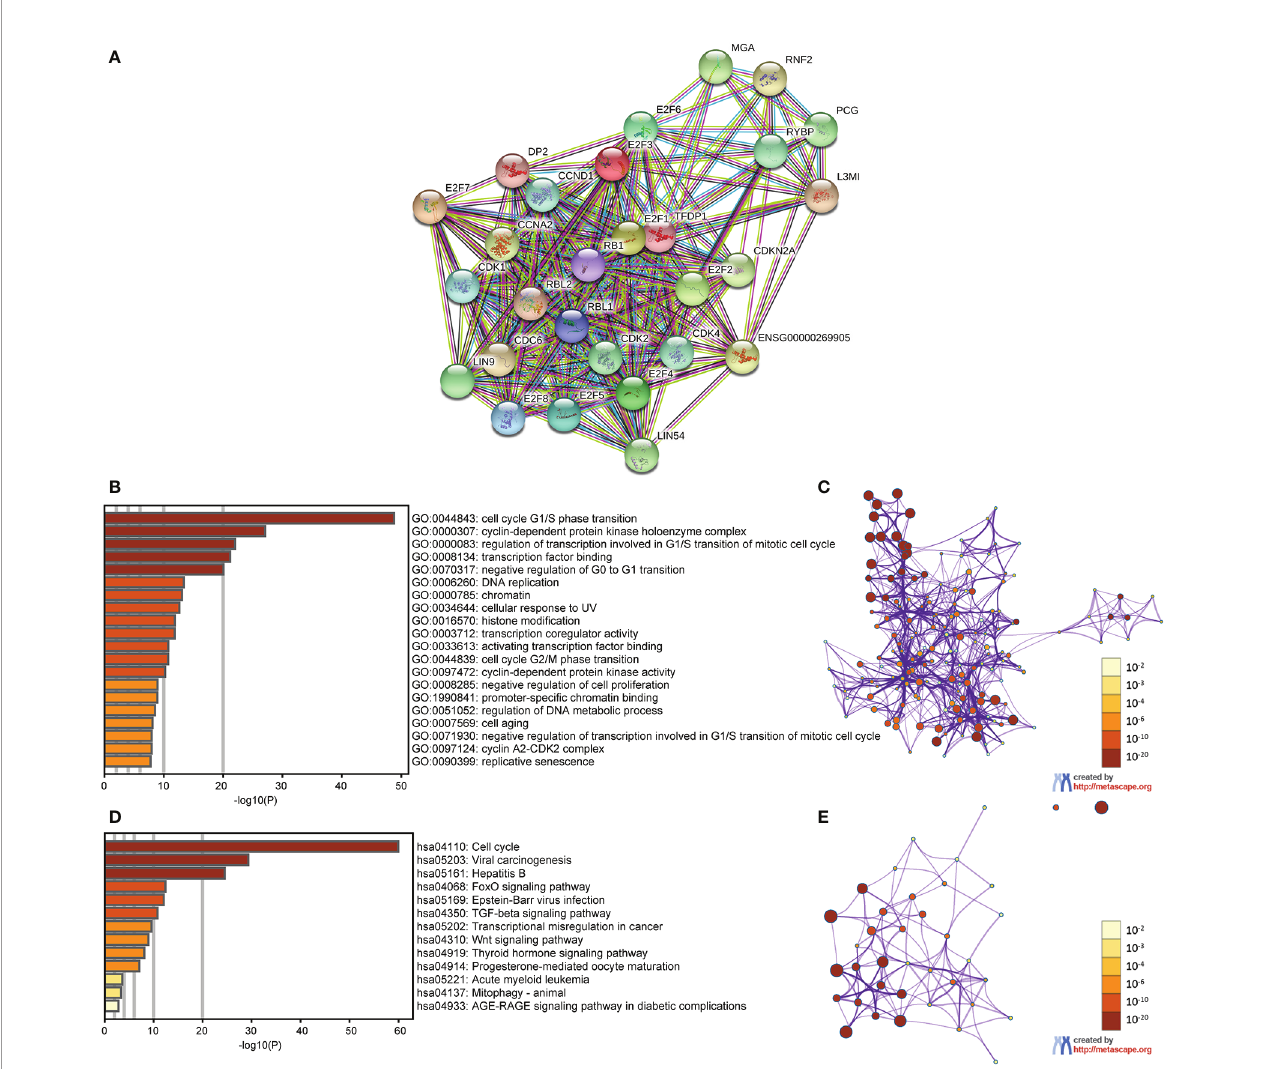
FIGURE 8 | PPI and functional enrichment analysis of E2Fs in patients with PAAD (STRING and Metascape). (A) Protein – protein interaction network of different expressed E2Fs. (B) E2Fs gene ontology (GO) enriched terms, colored by P -values. (C) Network of GO enriched terms colored by P -value, where terms containing more genes tend to have a more signi fi cant P -value. (D) E2Fs Kyoto Encyclopedia of Genes and Genomes (KEGG) enriched terms, colored by P -values. (E) Network of KEGG enriched terms colored by P -value, where terms containing more genes tend to have a more signi fi cant P